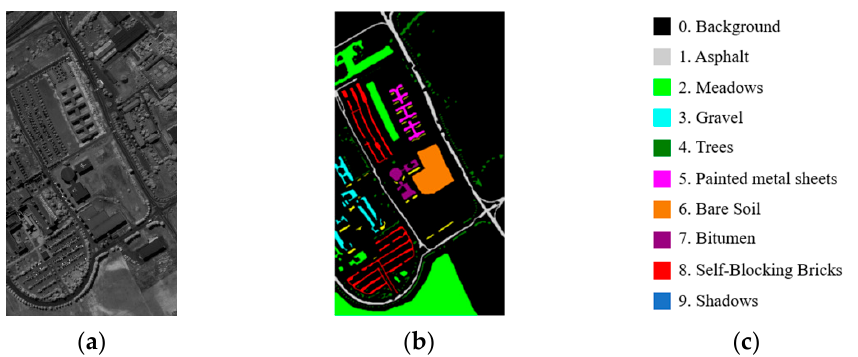
Figure 4. Pavia image scene. ( a ) Band 80th; ( b ) Ground truth map for nine classes; ( c ) Ground truth class label.